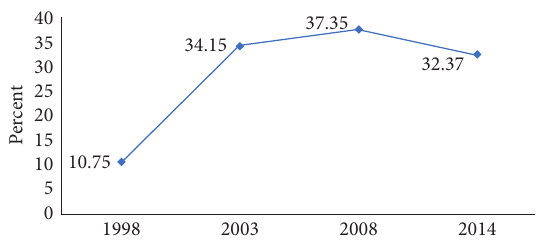
Figure 1: Trend of CK of HIV and AIDS among Ghanaians. Table 2: Cross tabulation of survey years and CK of HIV and AIDS.